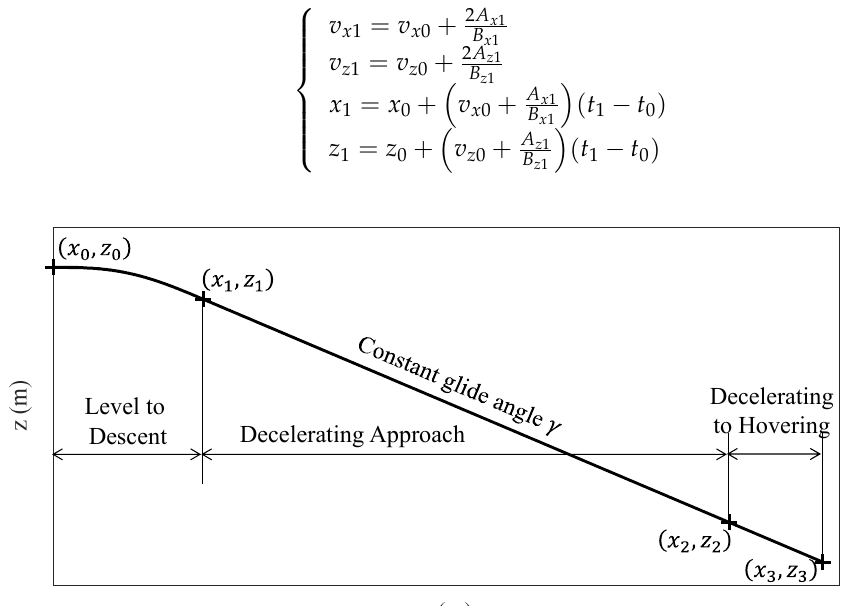
Figure 11. Flight path for Approach-to-Hovering task.